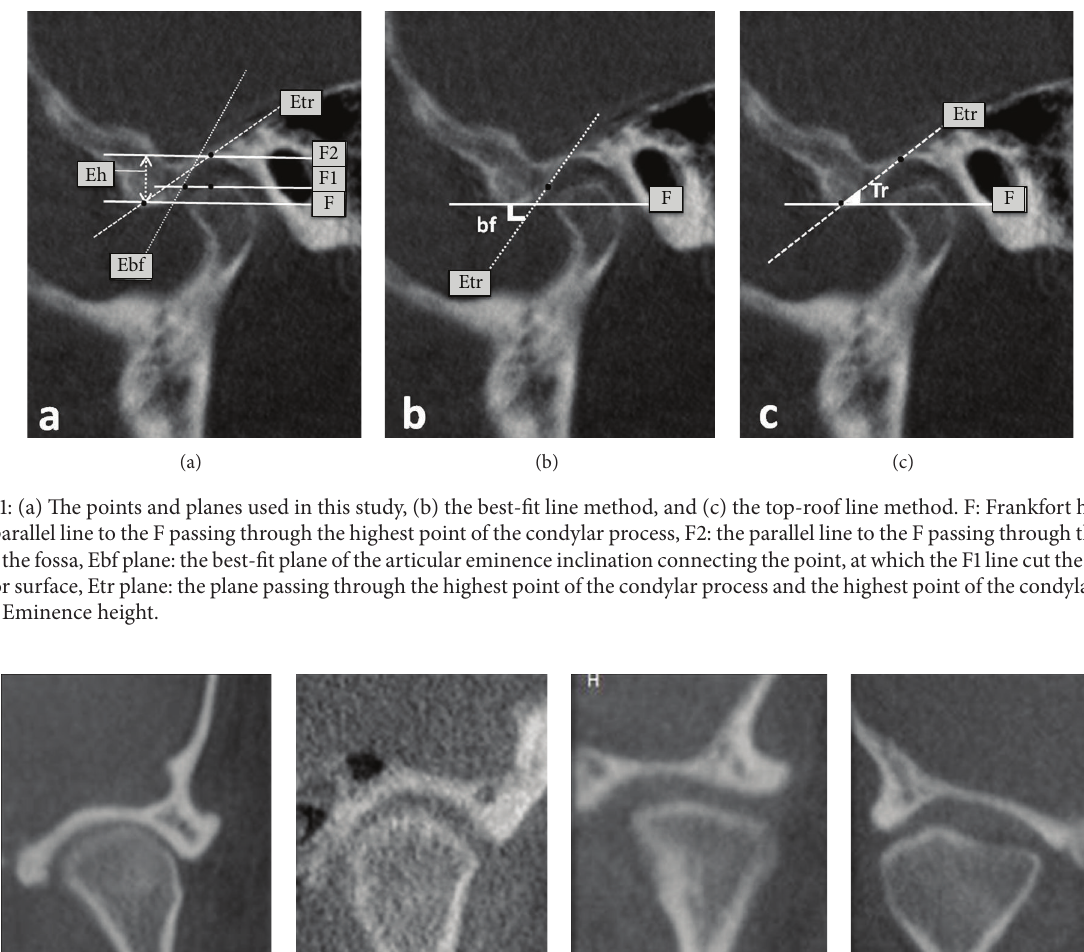
significant difference was found between RGF thickness and gender ( 𝑃 > 0.05